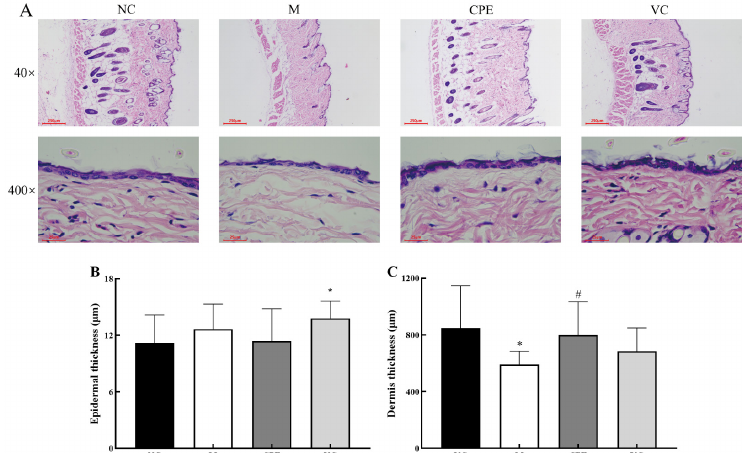
Figure 4. Results of epidermal and dermal thickness in mice skin with HE staining. Note: ( A ): HE-stained sections of skin tissue in each group; ( B ): Epidermal thickness of skin tissue in each group; ( C ): Dermal